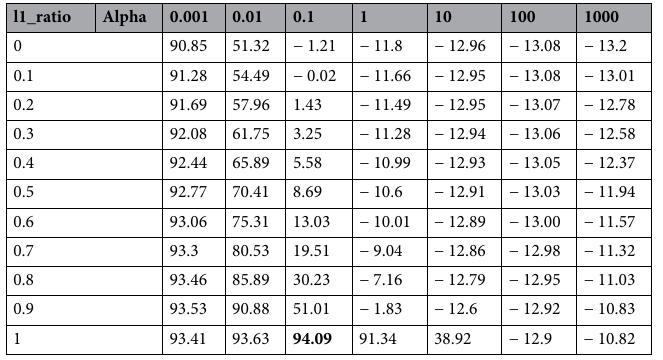
Table 5. Coefficient of determination for various values of alpha and l 1 _ratio for ElasticNet linear regression for weekly